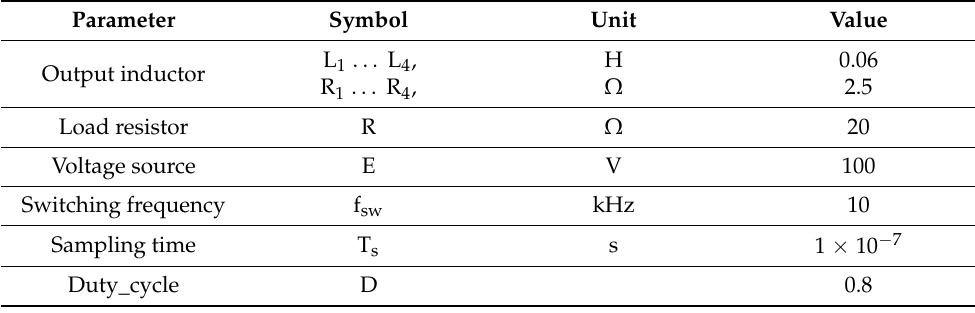
Table 4. Parameters of five-level DC/AC converter.